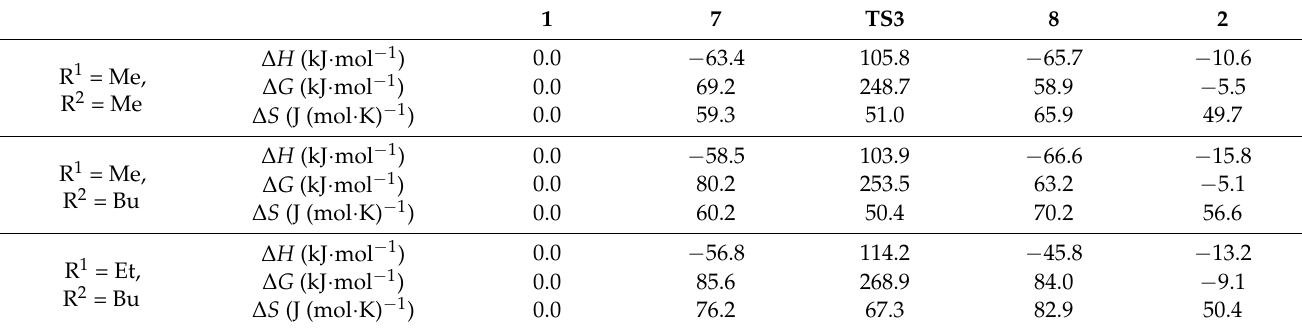
computations at the M062X/6–311+G (d,p) level of theory considering the solvent effect of the corresponding